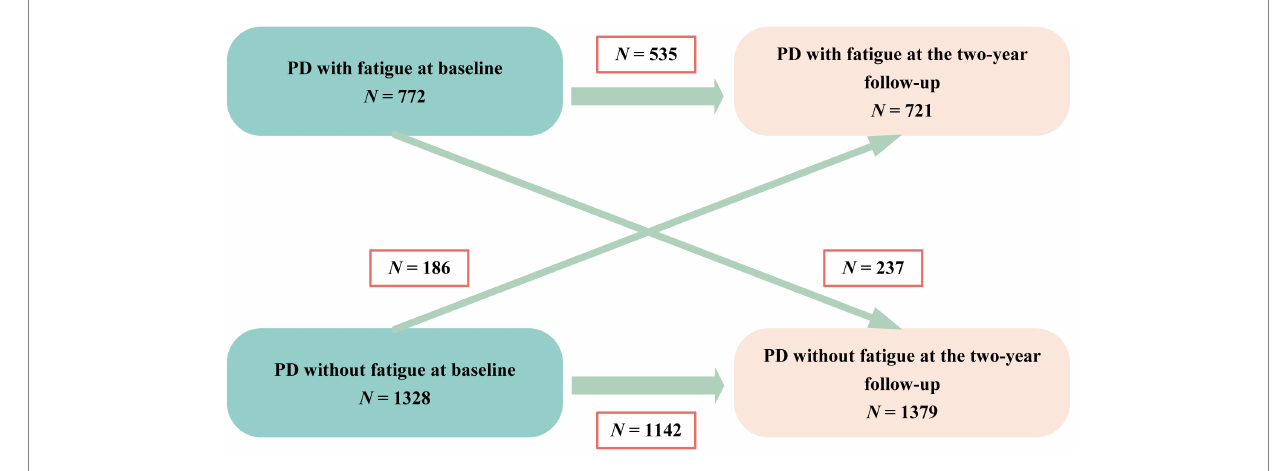
FIGURE 1 Diagram of fatigue change over time. PD, Parkinson’s